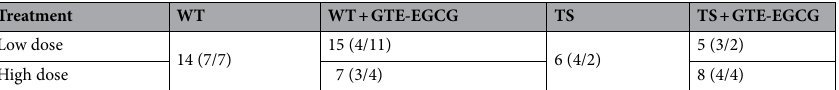
Table 1. Mouse sample composition by experiment of low and high dose GTE-EGCG treatment. Sample sizes of treated and untreated wildtype (WT) and trisomic (TS) mice are provided, showing total number of mice, as well as number of mice separated by sex (Female/Male). Since permutation tests based on Procrustes distances between male and female mice showed that there are no significant facial shape differences due to sex ( P = 0.2586) and male and female mice completely overlapped on the morphospace defined by a Principal Component Analysis (Fig. S2), we analysed the pooled data to increase the sample sizes and the robustness of the analyses.